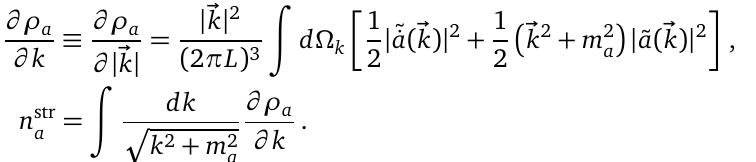
Figure 23: The time evolution of the comoving number density (left) and of the mean square axion field amplitude (right) for different values of ξ (cid:63) log (cid:63) , with x α = 8. The colors on the right figure correspond to the same values of ξ the left. The lower lines, below the shaded regions, are the same observables com- puted with oscillons masked, which only makes sense at late times once these are well defined objects. It can be seen that after a transient the comoving axion num- ber density approaches a constant value. Meanwhile, at early times the mean field amplitude evolves as relativistic matter, and at late times as nonrelativistic matter, as